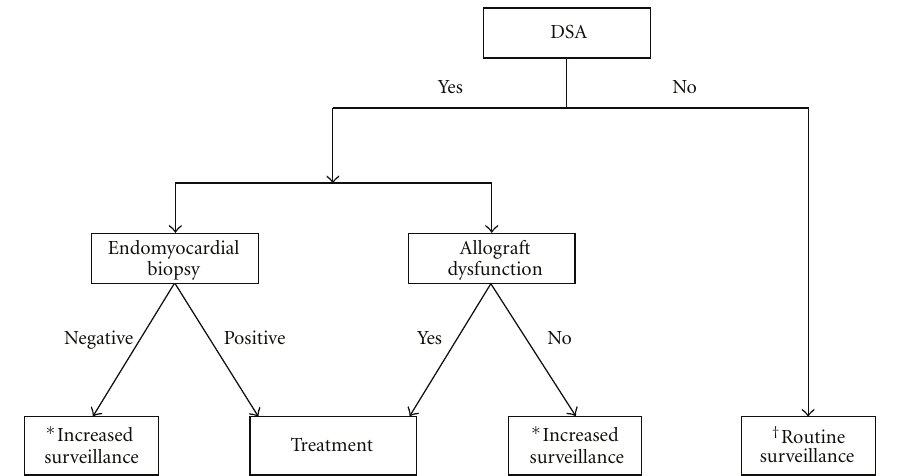
Figure 3: Proposed DSA treatment algorithm. AMR: antibody-mediated rejection, DSA: donor-specific antibodies. ∗ Assessment of allograft function every month and DSA every 3 months until two negative or unchanged results. † DSA monitoring at week 2, months 1, 3, 6, and 12 in first year after transplant and annually